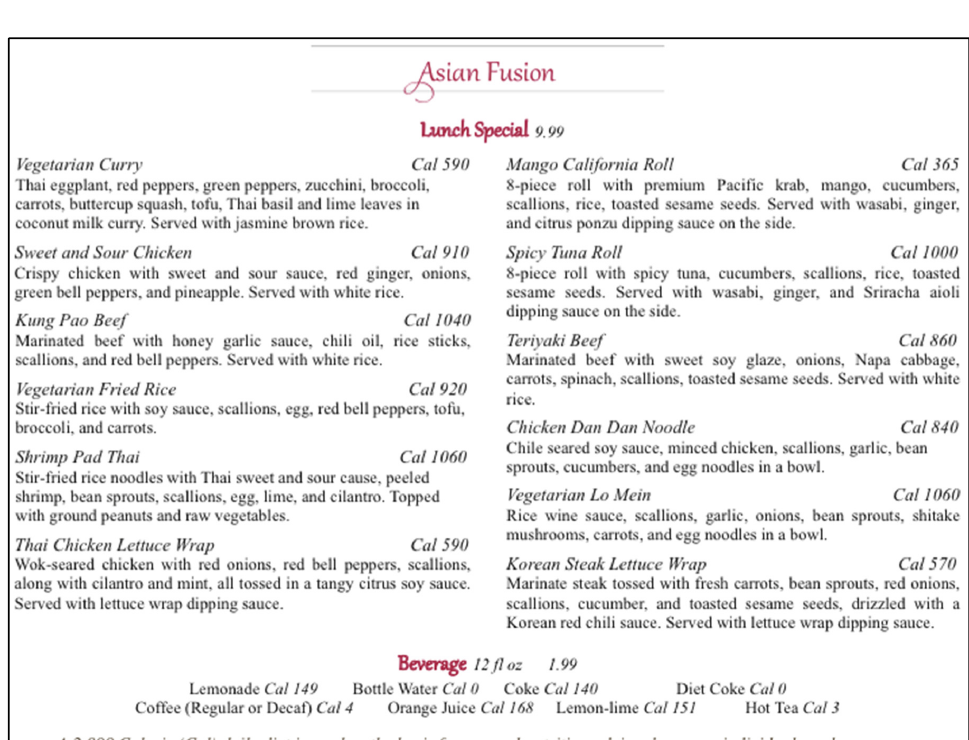
Figure A3. Asian Fusion Sweet Spot Menu.